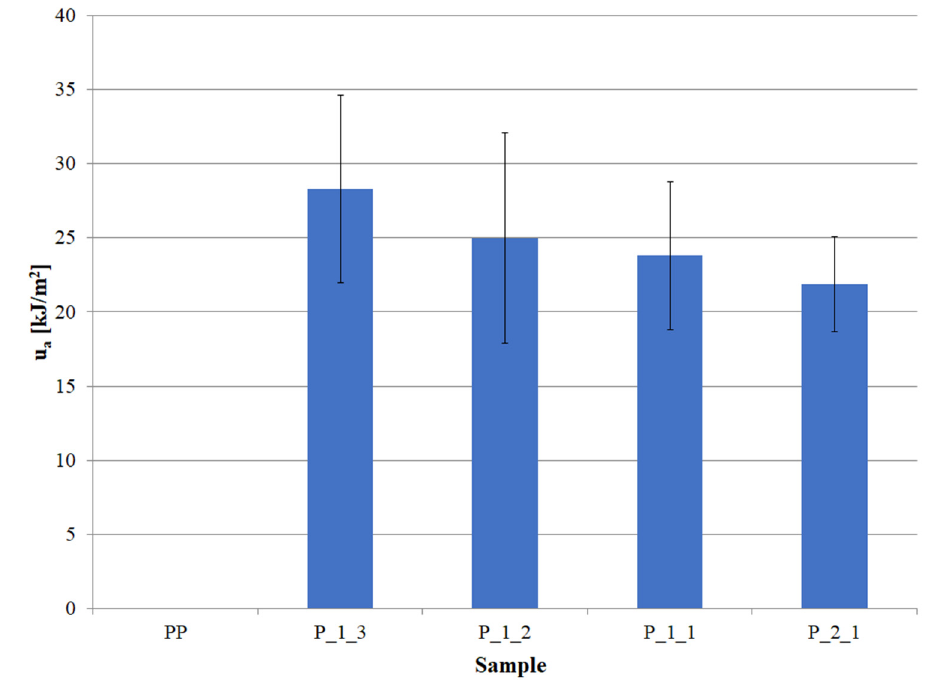
Figure 6. The impact strength (u a ) of individual samples.